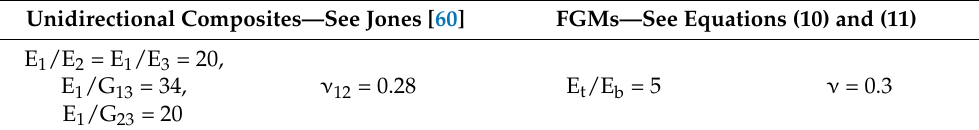
Table 1. Mechanical properties. Unidirectional Composites—See Jones [60] FGMs—See Equations (10) and